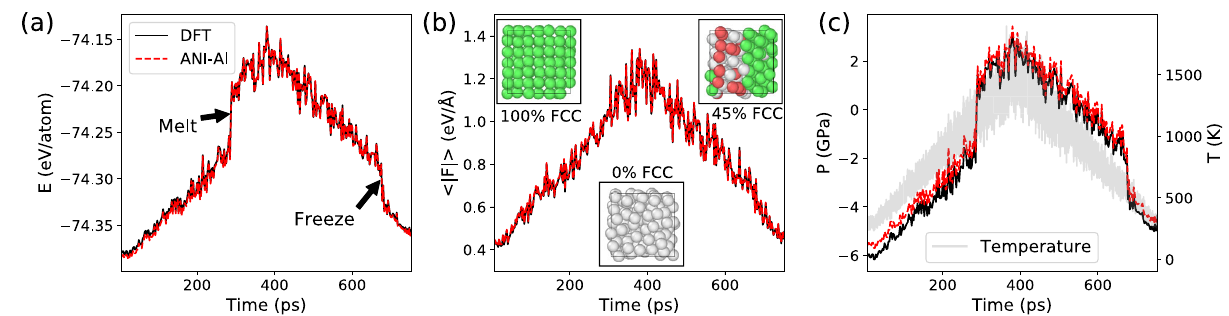
Fig. 6 ML-driven molecular dynamics, showing melting and freezing processes. The system is heated from 300 to 1500 K, and cooled back to 300 K. Reference DFT calculations (black) are used to verify the ANI-Al predictions (red) for ( a ) the energy, ( b ) mean (avg.) force, and ( c ) pressure. The instantaneous temperature is shown in gray on panel ( c ). Panel ( b ) insets show the local atomic structure (green — FCC; gray — disordered; red — HCP) at snapshots before melting, after melting, and